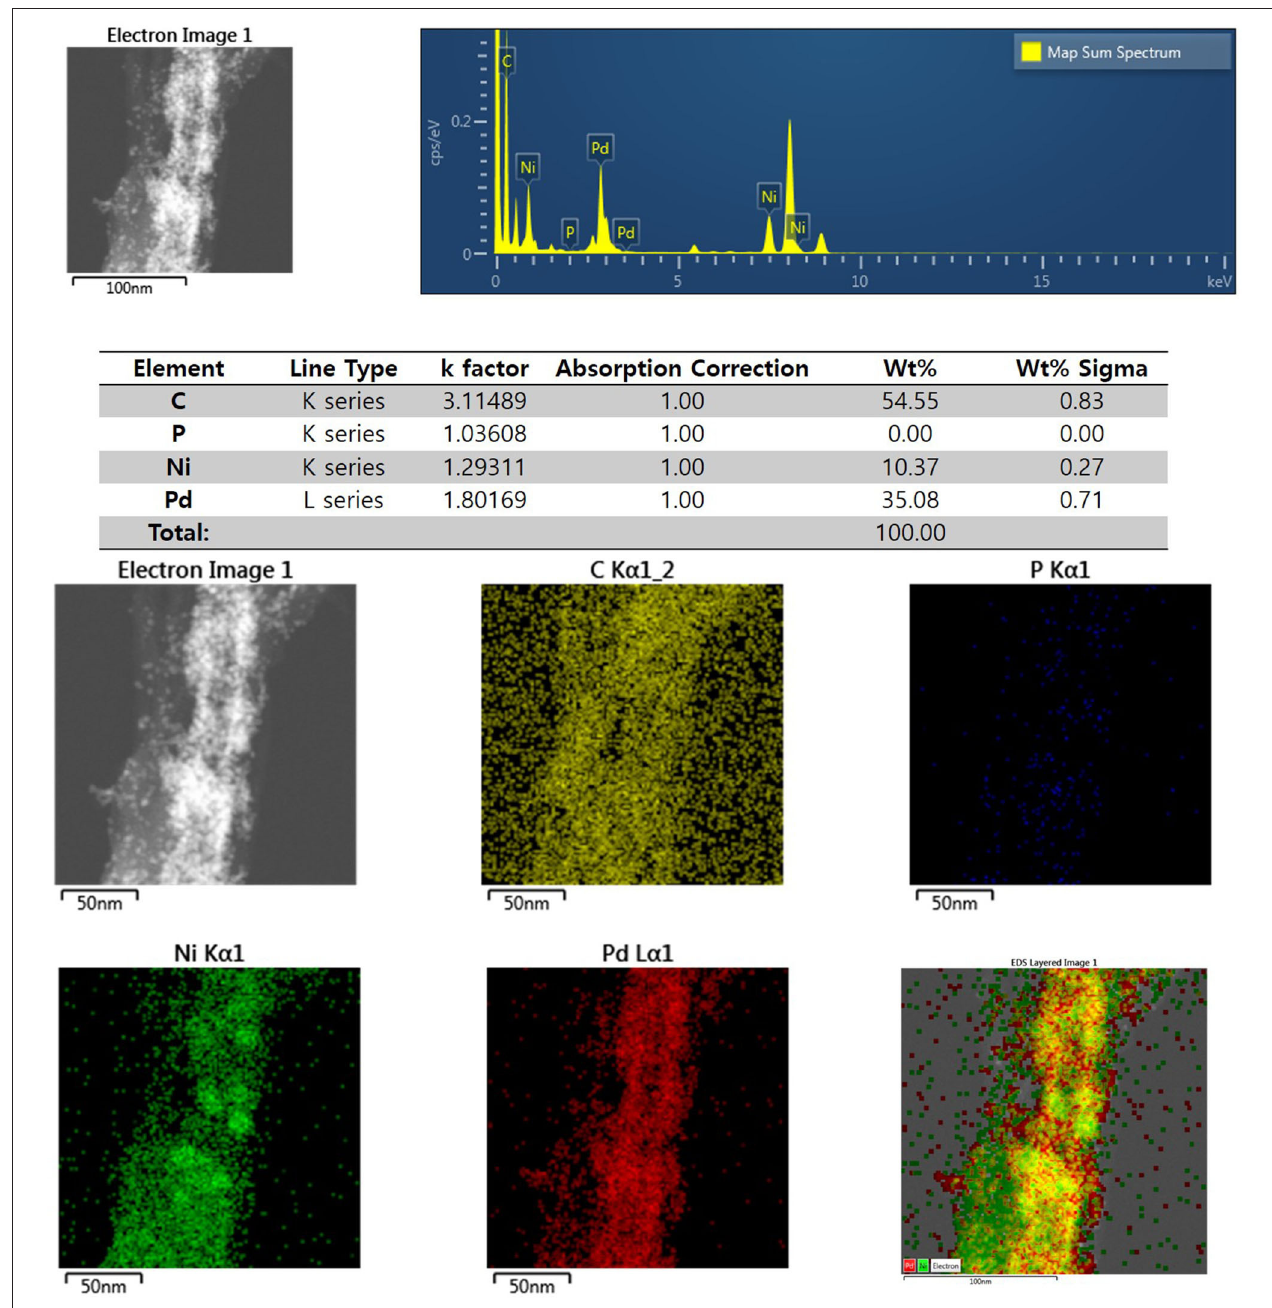
FIGURE 7 | EDS elemental analysis results and elemental mapping images of Ni-Pd(P)/MWCNT catalyst.